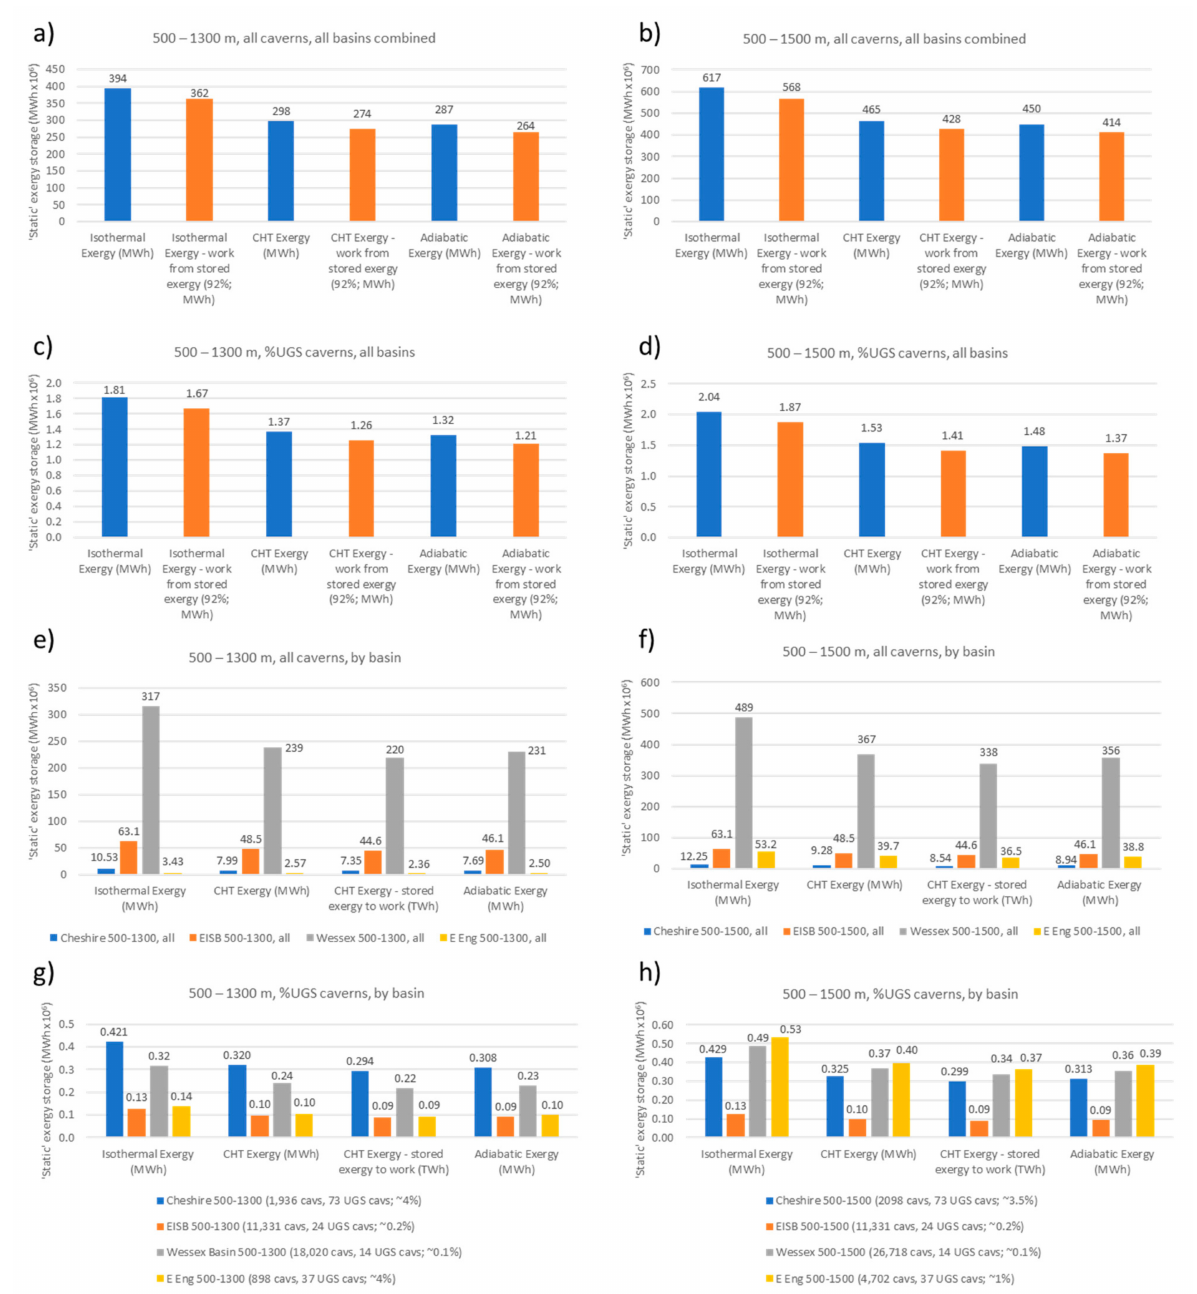
Figure 3. Plots of theoretical ‘static’ (one-fill) exergy storage estimates for the three thermal models for all potentially available caverns over the two depth ranges for all caverns with the basins studied. Parts ( a , b ) show graphs for combined totals from each basin for the two depth ranges, together with the estimated stored exergy to work for each thermal model. Parts ( c , d ) show graphs for the estimated stored exergy to work for each thermal model based upon percentages related to UGS numbers of the combined totals from each basin for the two depth ranges. Parts ( e , f ) show graphs breaking storage down by basin for the three thermal models, including stored exergy to work estimate for the CHT model also shown, with outlines data ranges being those pertinent to CHT model storage data presented in Figure 4. Parts ( g , h ) show graphs for estimates based upon a percentage related to the number of operation and/or planned UGS caverns in the